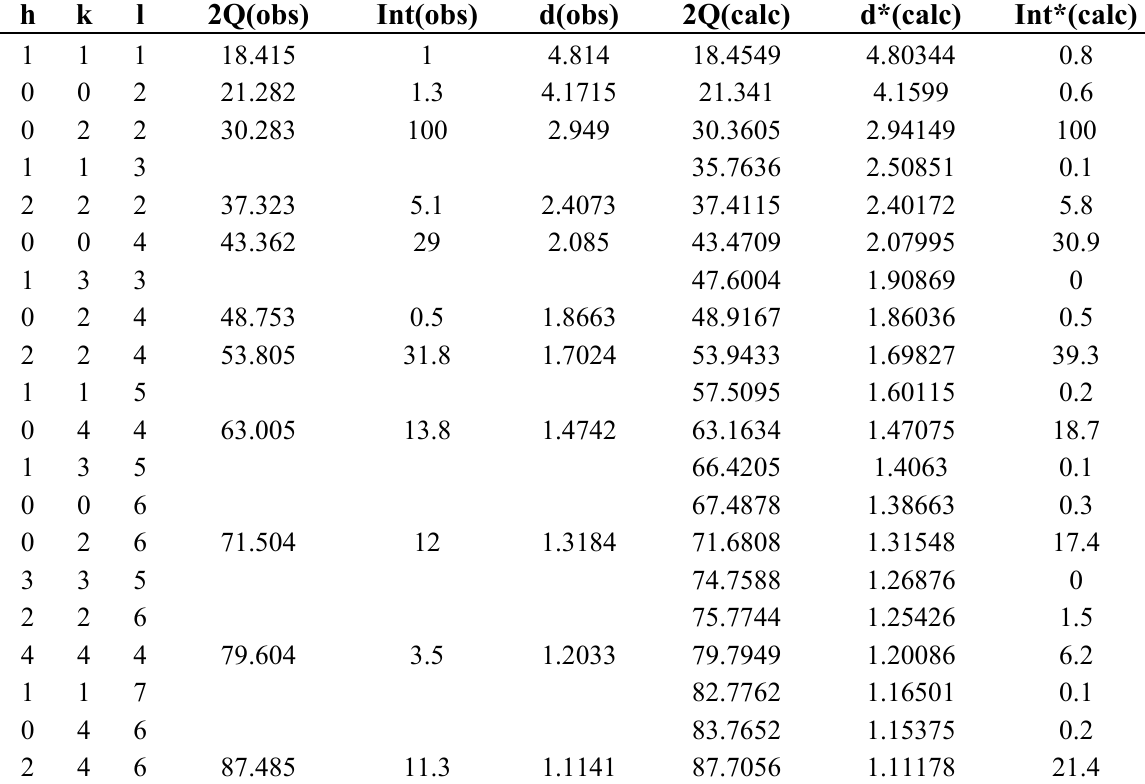
Table 1. Table of observed and calculated XRD characteristics for Ba values are based on the earlier work of Battle et al. with a Fm-3m